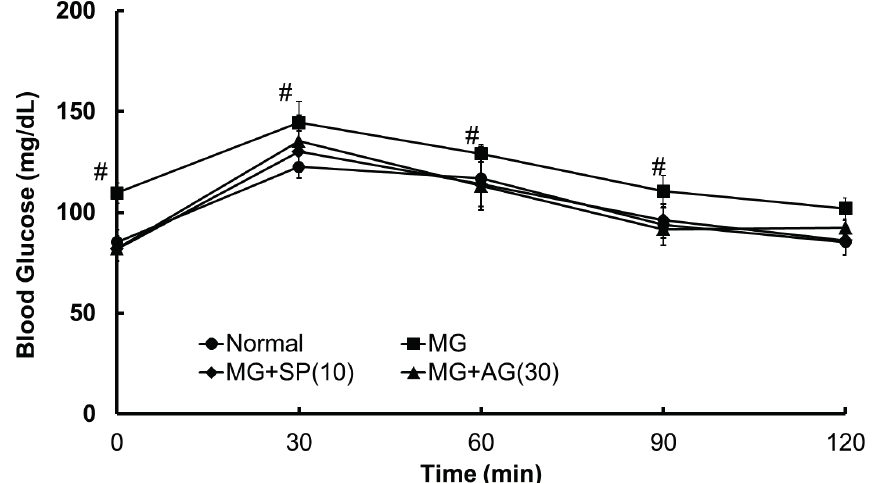
Figure 2. The effects of scopoletin (SP) and aminoguanidine (AG) on OGTT at week-12.